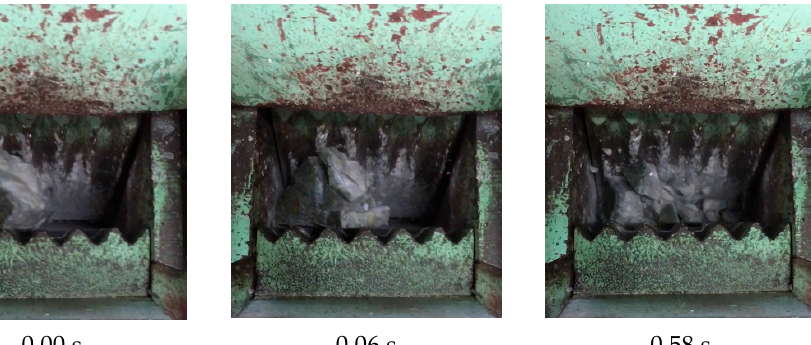
Figure 8. Perspective view of DEM simulation of the laboratory jaw crusher ( a ) and particle velocities profile through the crushing chamber ( b ).